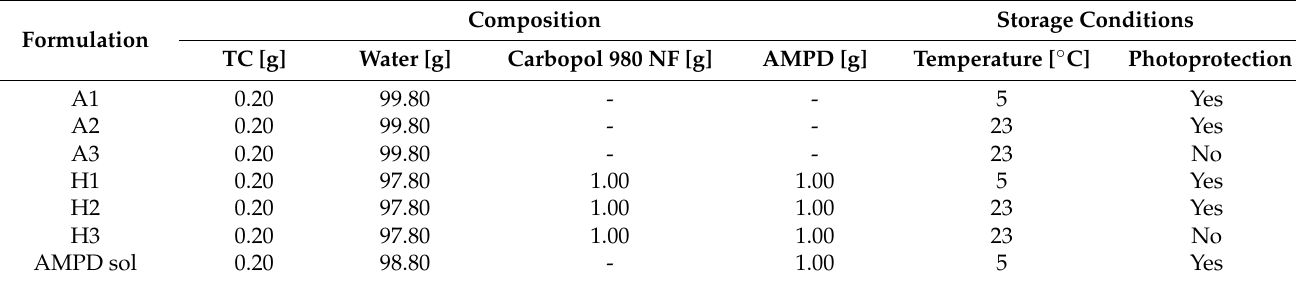
Table 1. Composition of samples and storage